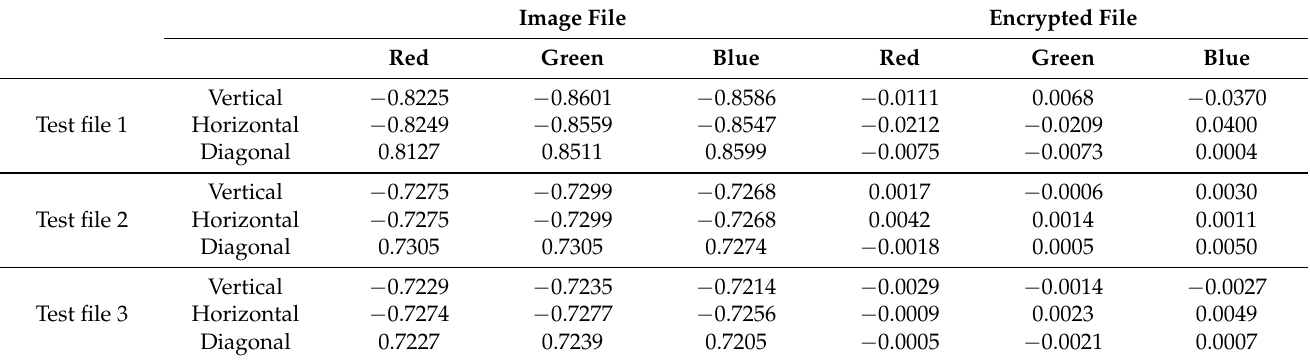
Table 4. Correlations of adjacent pixels of the image version of the text and the encrypted image. Image File Encrypted File Red